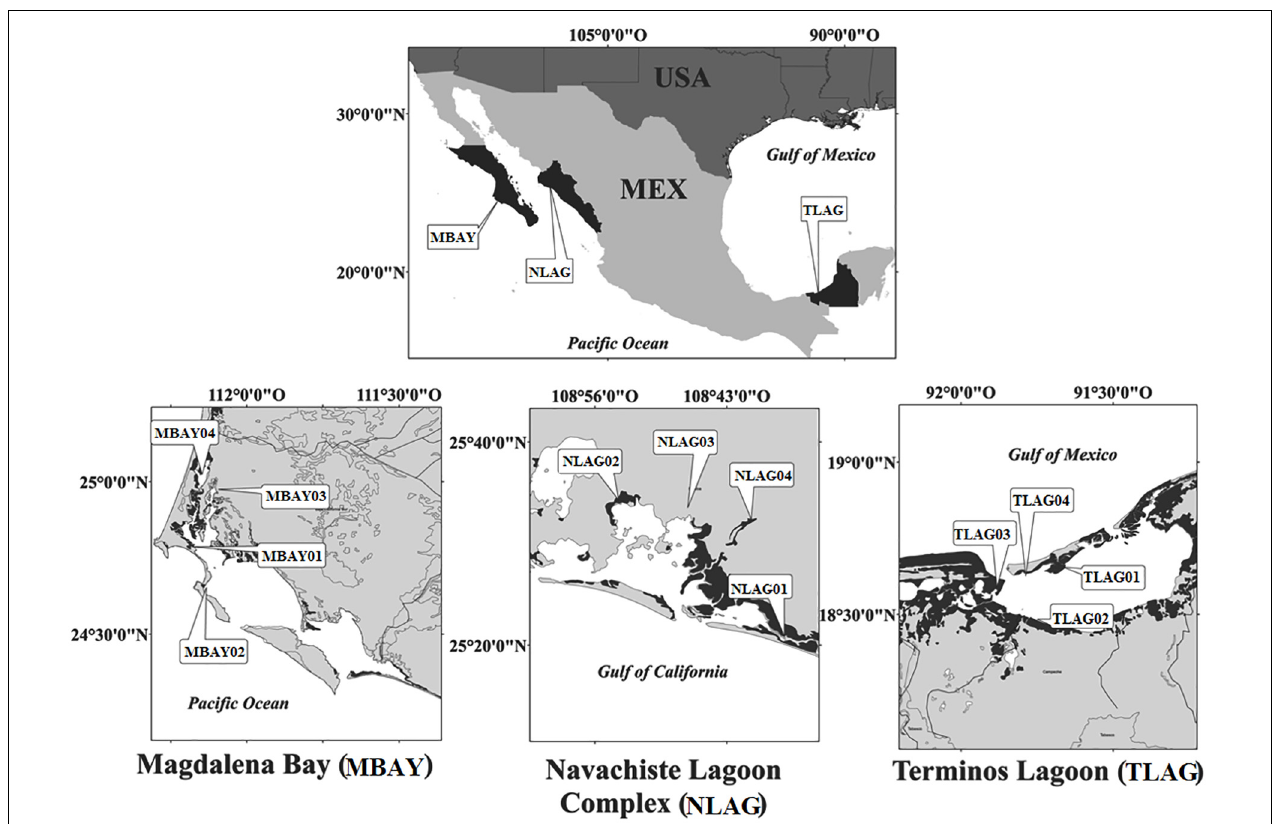
FIGURE 1 | Geographical location of the study area and location of sampling sites in Magdalena Bay (MBAY) (A) , Navachiste Lagoon complex (NLAG) (B) , and Terminos Lagoon (TLAG) (C)